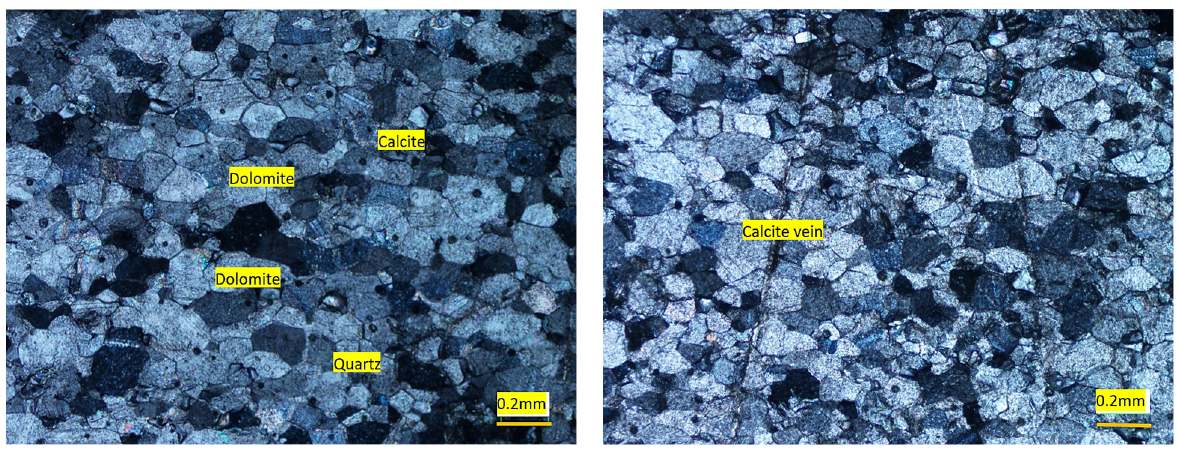
Figure 10. Photomicrographs of calcareous dolostone from Swabi area showing dolomite, calcite, quartz and calcite veins cross cutting the rock.